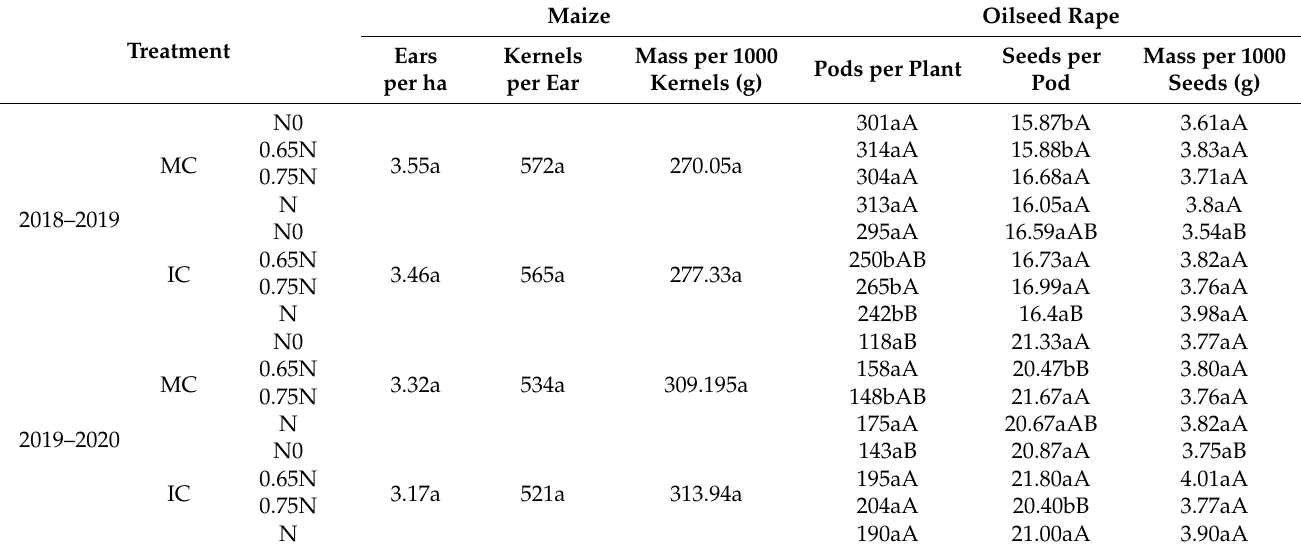
Table 2. Yield components of maize and oilseed rape under different treatments. Maize Oilseed Rape Treatment